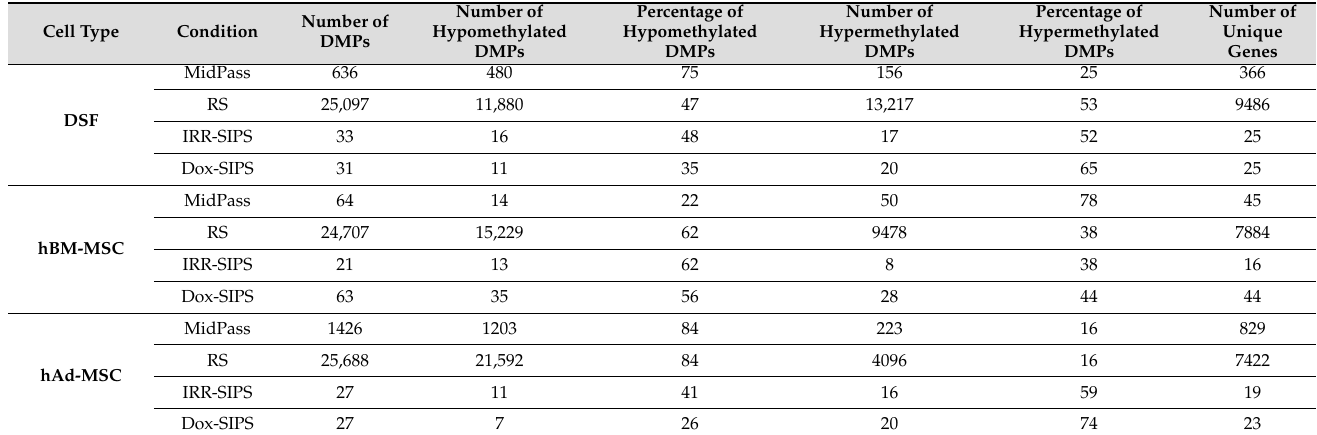
Table 2. Summarization of the sets of differentially methylated positions and